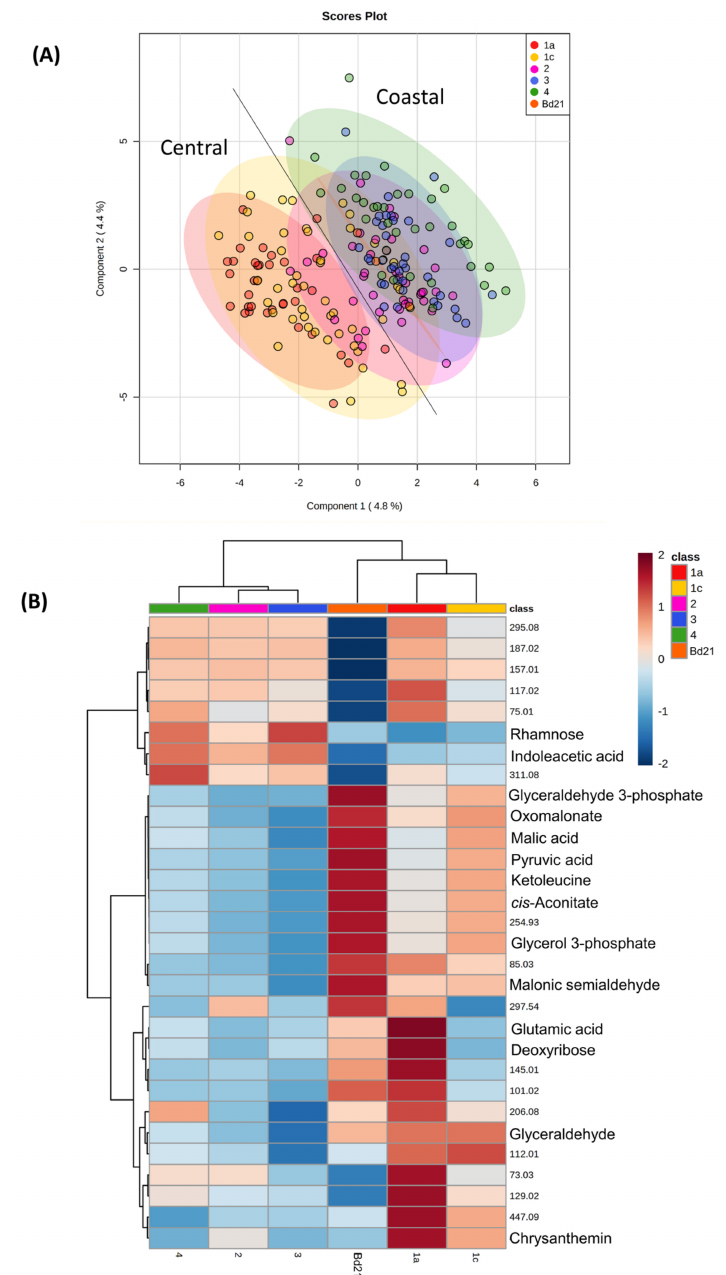
Figure 1. Metabolomic variation in Brachypodium accessions from different climatic regions of Turkey. Metabolite profiles from the leaves of eight-week-old Brachypodium seedlings were derived by Flow Infusion Electrospray-High Resolution Mass Spectroscopy (FIE-HRMS). Accessions are classified according of Turkish climate region of origin; 1a (red), 1c (yellow), 2 (purple), 3 (blue) and 4 (green) [6]. Profiles from the reference accession Bd21 are represented by dark orange points or block as relevant. Profiles were initially assessed using ( A ) Partial Least Square—Discriminant Analysis (PLS-DA). The major sources of variation were identified using one-way ANOVA correcting for false discovery rates (FDR). ( B ) Key variables are displayed as a heatmap. Some mass-ions ( m/z ) were identified from comparison with databases and are labelled with names. Where m/z could not be identified these are given as the raw data